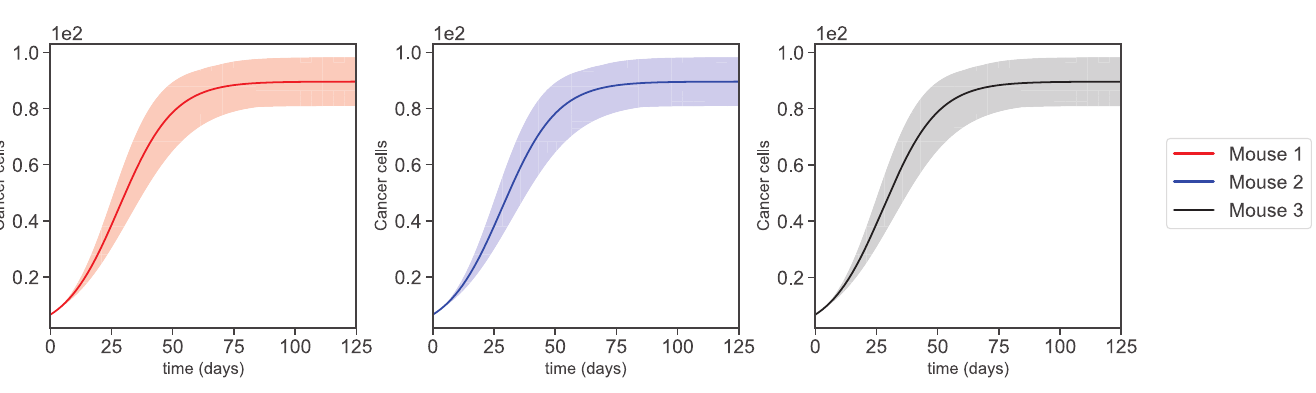
Fig 6. Varying dynamics. The transparent regions are acquired by 20% perturbation of all the sensitive parameters in Figs 4 and 5.